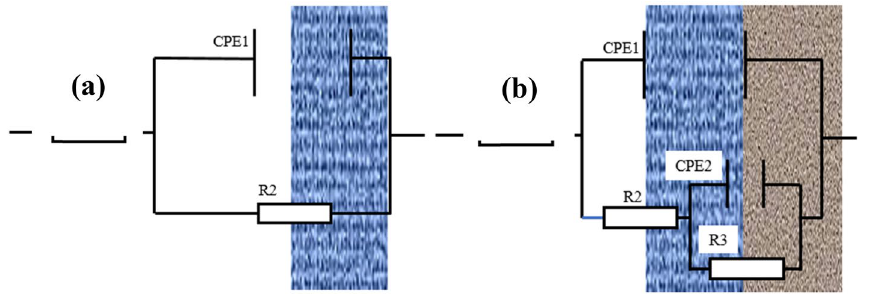
Figure 8. The equivalent circuit model used to fit the impedance